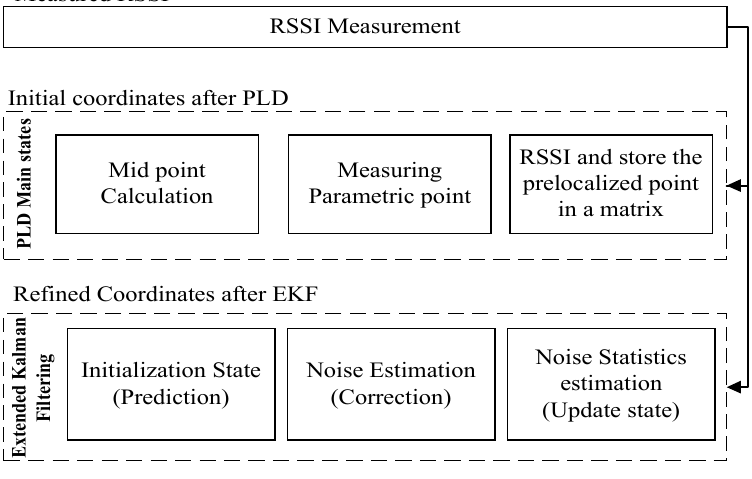
Figure 3. Extended Kalman filtering implemented on PLD coordinates.